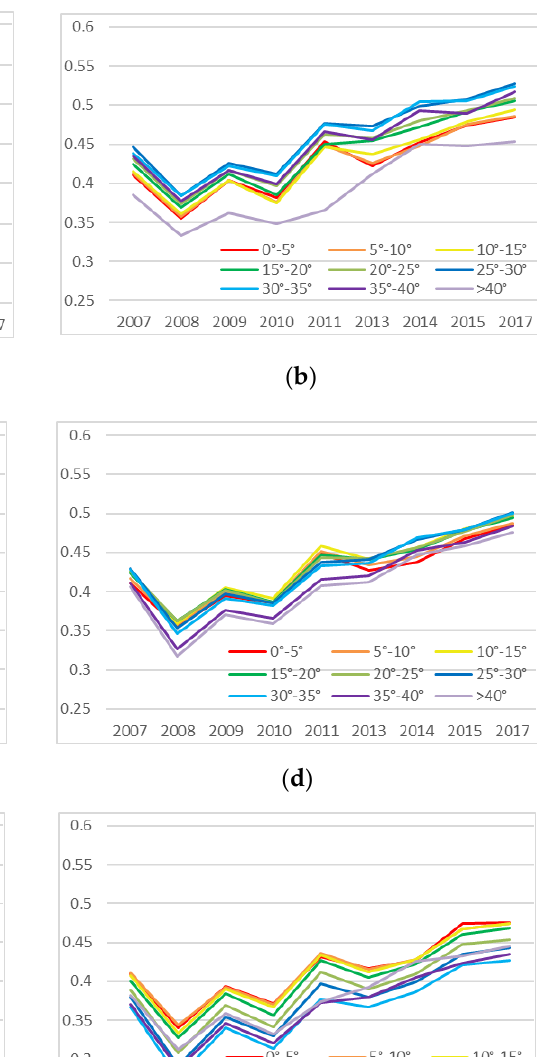
Figure 13. Broken-line graph showing EVI changes from 2007 to 2017, in all slope zones, for six forest types: ( a ) CF; ( b ) PM; ( c ) CM; ( d ) CABM; ( e ) BM; and ( f ) OHB. Table 14. Disaster-impact-analysis results for six forest types in different slope zones.